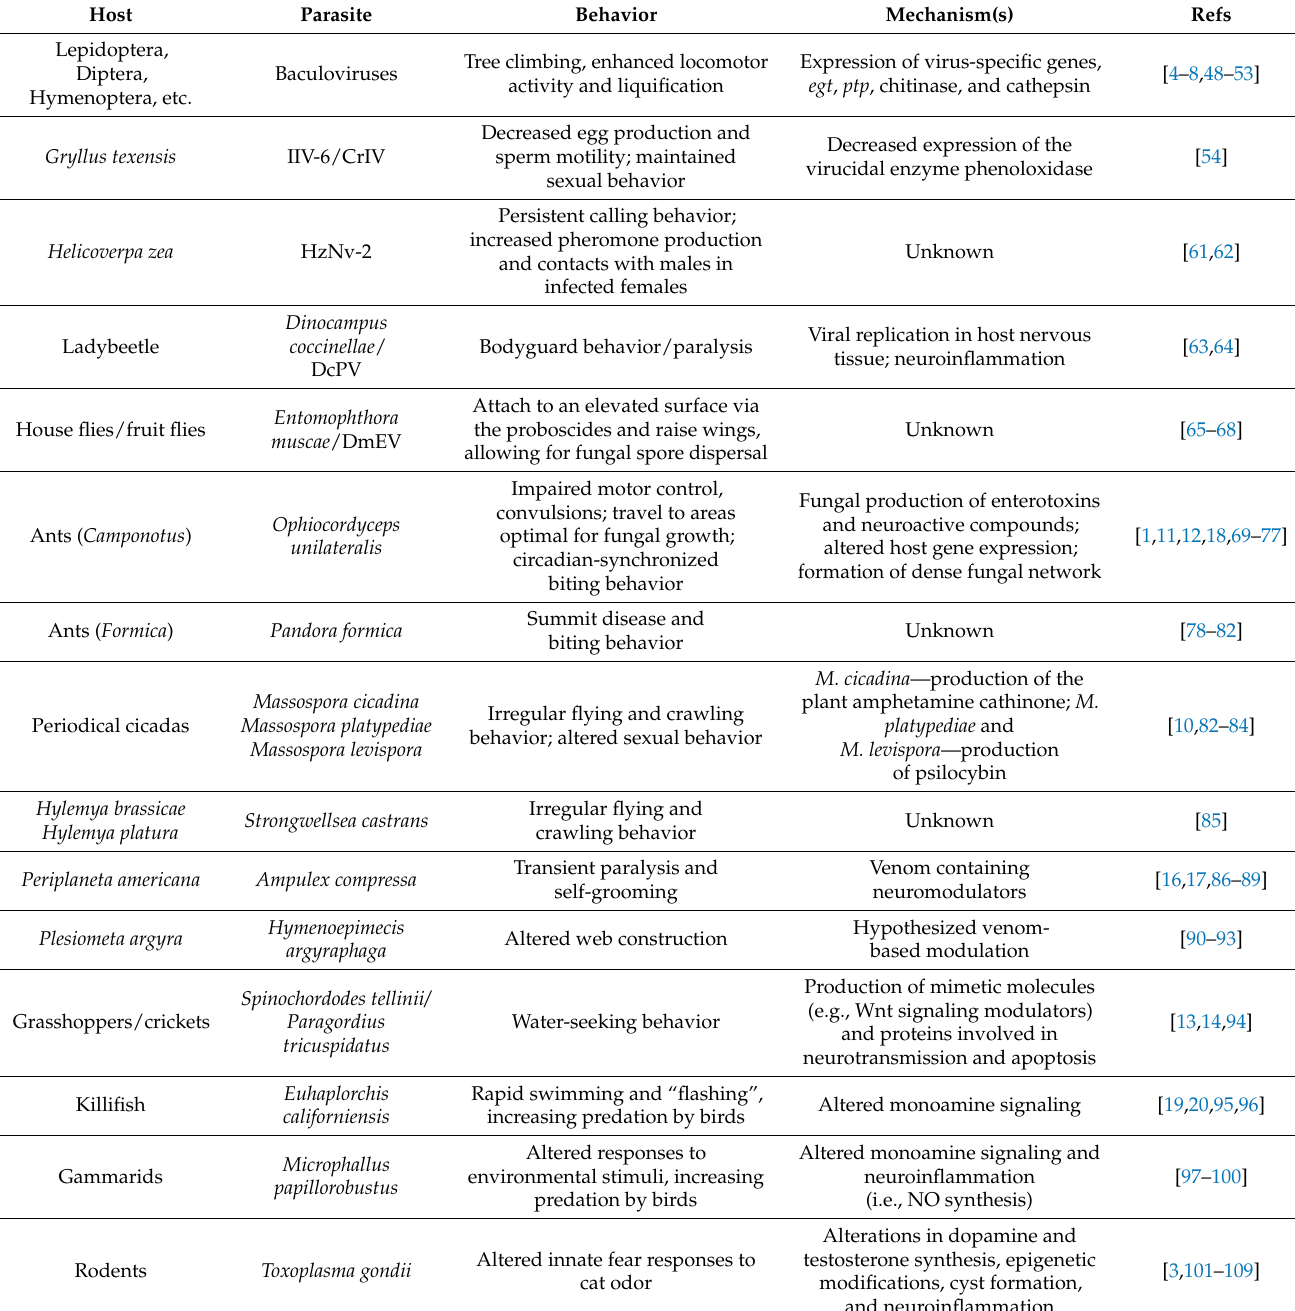
Table 1. Host–parasite/parasitoid systems, behavioral changes, and hypothesized mechanisms 1